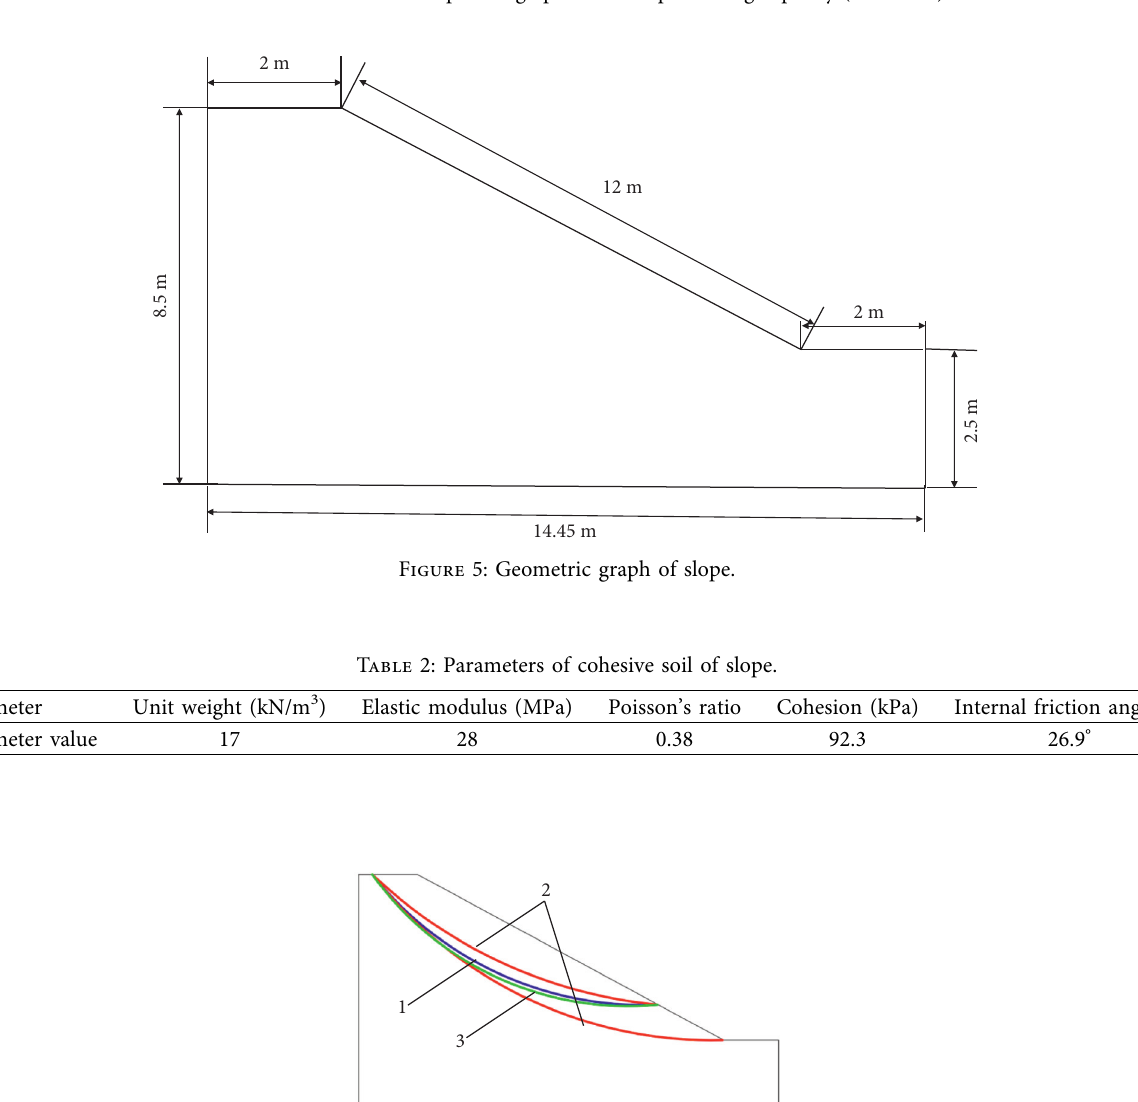
Figure 4: Arc curve of abrupt change points of slope bearing capacity (unit: mm).